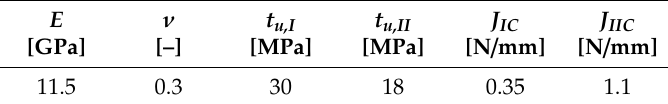
Table 3. Mechanical properties of adhesive